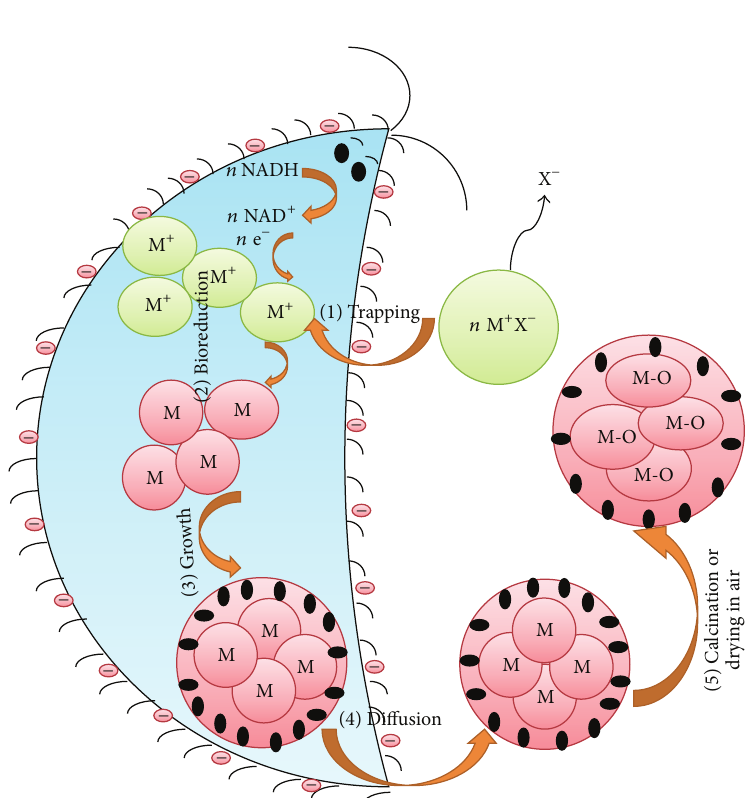
Figure 2: Mechanism of microbes mediated synthesis of metal and metal oxide nanoparticles.